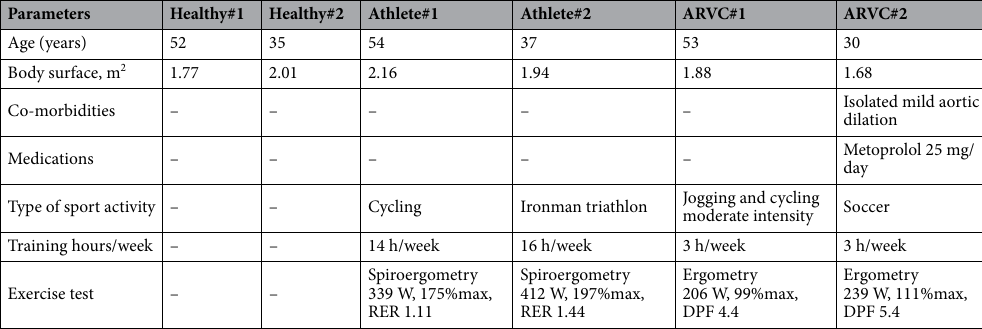
Table 1. Baseline characteristics. DPF double-product factor, RE respiratory exchange rate.